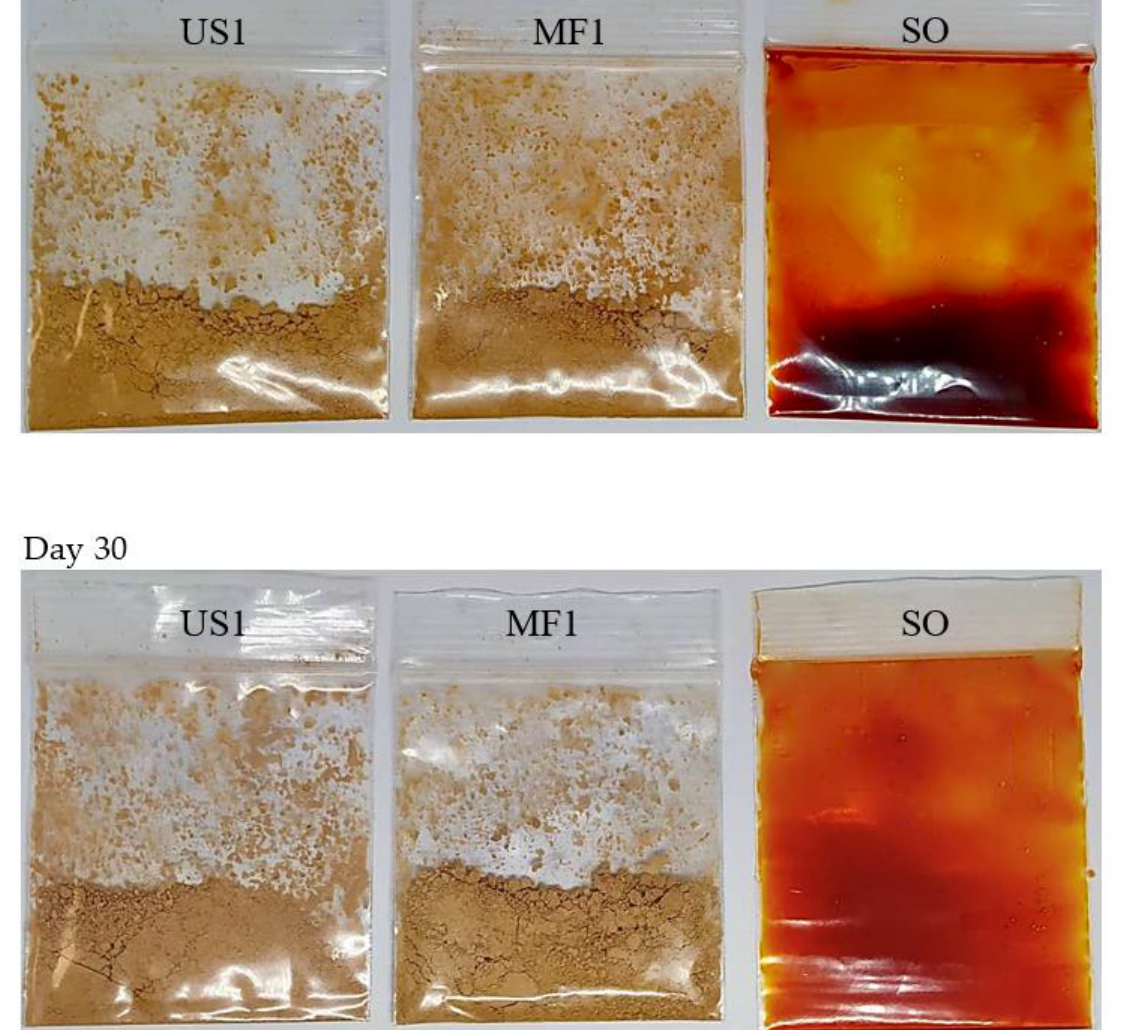
Figure 5. Images of SO, US1 and MF1 samples packed in zip lock bags at day 0 and day 30 of storage at room temperature (28–30 ◦ C). SO, shrimp oil; US1, ultrasonicated KBPI-KC-SO microcapsules containing 0.1% SO; MF1, microfluidized KBPI-KC-SO microcapsules containing 0.1% SO .